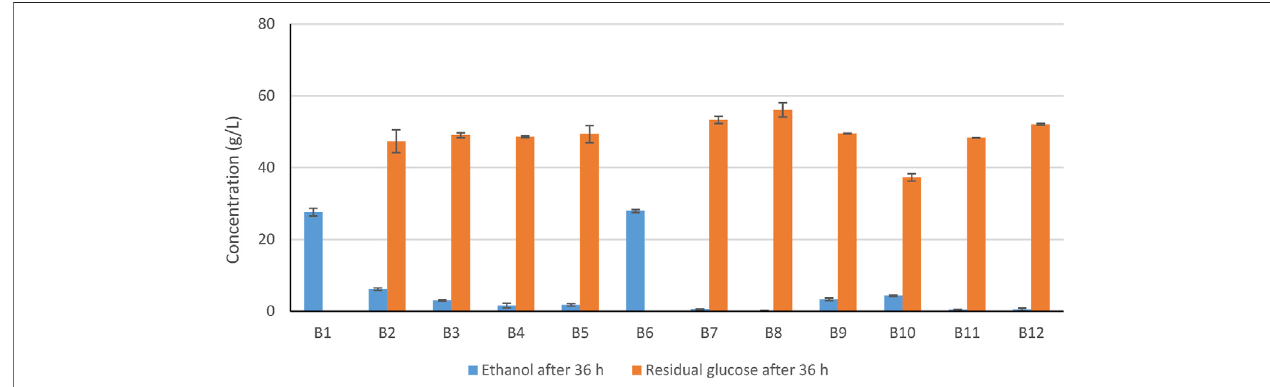
FIGURE 3 | Concentrations of ethanol and residual glucose after 36 h of HHF of Norway spruce slurry using different methods ( Table 2 ). Error bars indicate standard deviations.